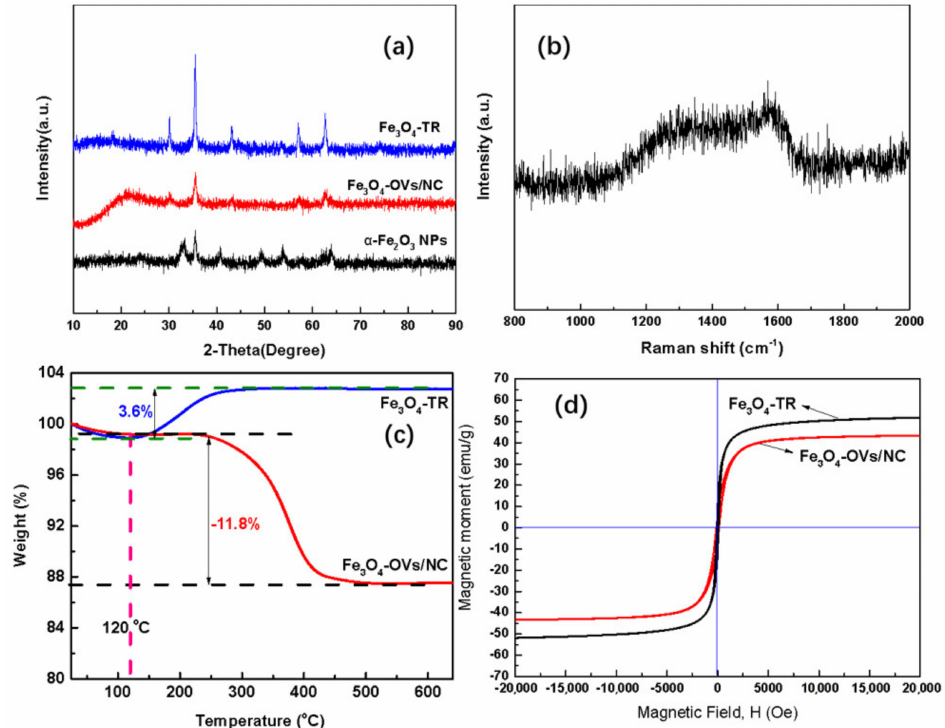
Figure 1. ( a ) XRD patterns of Fe 3 O 4 -OVs/NC, Fe 3 O 4 -TR and α -Fe 2 O 3 NPs (precursor). ( b ) Ra- man spectra of Fe 3 O 4 -OVs/NC. ( c ) Thermogravimetric curves of Fe 3 O 4 -TR and Fe 3 O 4 -OVs/NC. ( d ) Magnetization curve of Fe 3 O 4